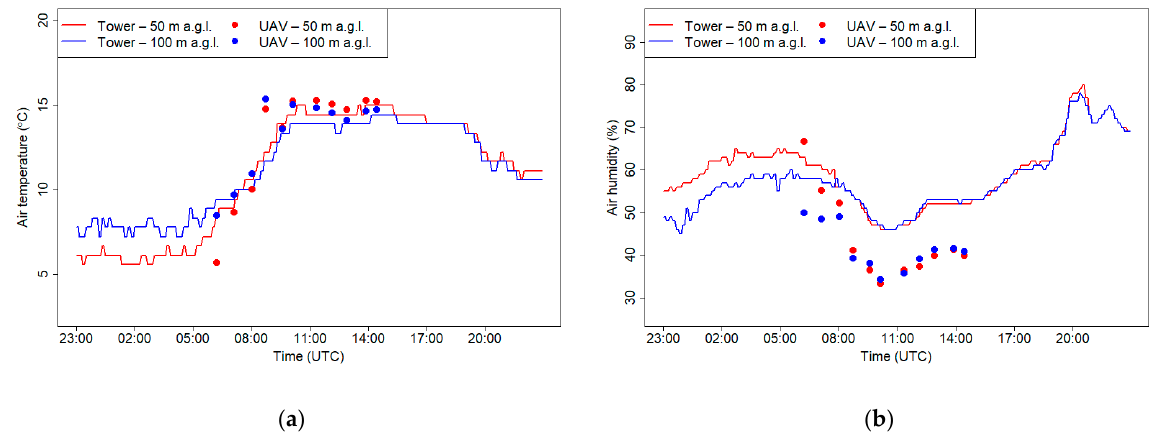
Figure 20. Air temperature ( a ) and relative humidity ( b ) at 50 and 100 m a.g.l. measured at the RTCN tower and by the UAV on 7 March 2019.